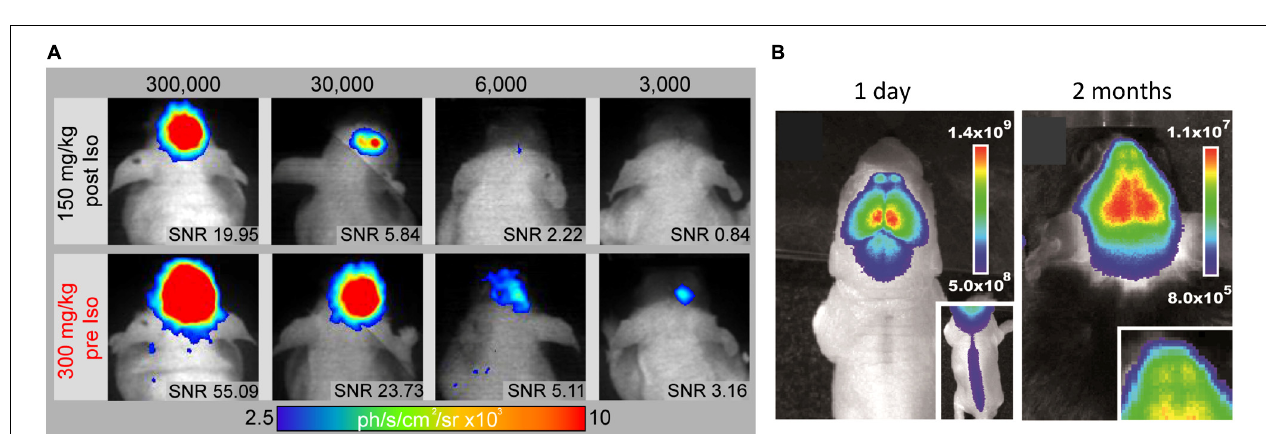
etal., 2009). (B) With increasing number of cortical grafts (confocal images upper row), the amplitude of cortical activation is reduced as displayed in color-coded maps (lower row) of cortical activation depicting the maximum of mean fluorescence intensity change (F/F 0 ) within 1024 ms recording interval. Images adapted with permission from Weerakkody etal. (2013).